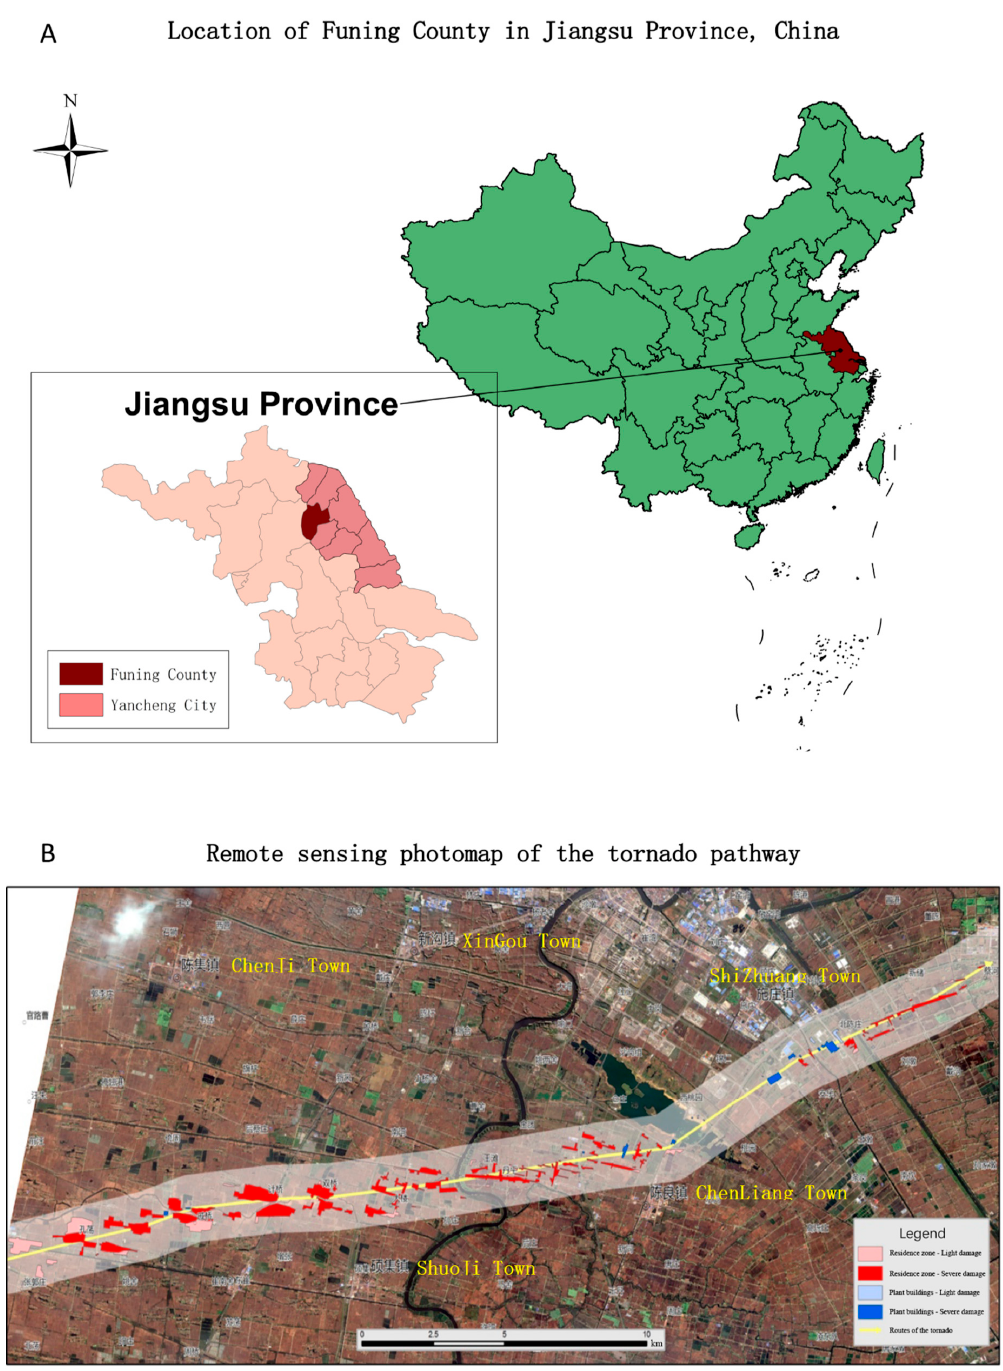
Figure 1. Location and pathway of the Funing tornado, 23 June 2016. ( A ) Location of Funing county in Jiangsu Province, China; ( B ) Remote sensing photomap of the tornado pathway. Jiangsu Province, China; ( B ) Remote sensing photomap of the tornado